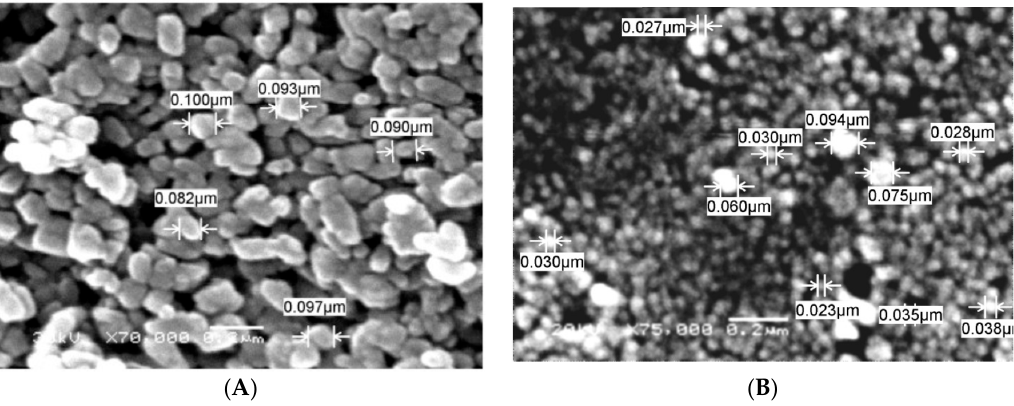
Figure 5. SEM morphological structure of ( A ) amine-functionalized silica gel (ANSG) and ( B ) magnetic amine-functionalized silica gel (MANSG).